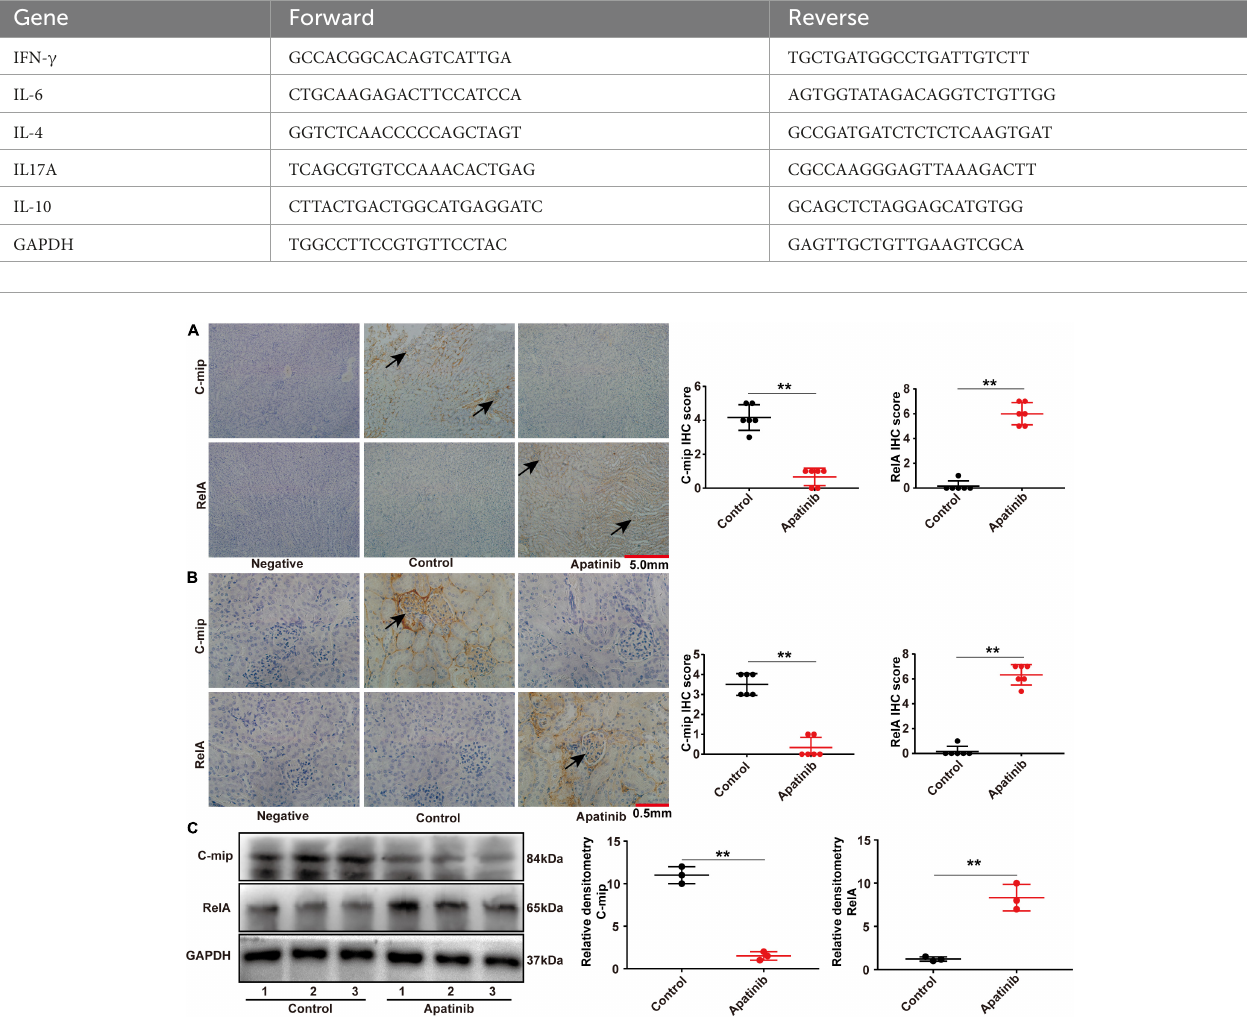
kits (Sigma, USA), Periodic Acid Schiff (PAS) and hematoxylin and eosin (H&E). The mean glomerular volume area was calculated based on the average volume of 30 glomeruli in each group, and the equation GV = ( β / κ ) × GA3/2 (1), where β = 1.38, the shape coefficient of spheres (the idealized shape of glomeruli), κ = 1.1, the size distribution coefficient, and GA is the glomerular area (7). Tubular injury was detected as tubular injury score by using a method described previously (19, 20). The scoring criteria for staining results were as follows: Score 0, no tubular injury; Score 1, < 10% of tubules injured; Score 2, 10–25% of tubules injured; Score 3, 26–50% of tubules injured; Score 4, 51–75% of tubules injured; Score 5, > 75% of tubules